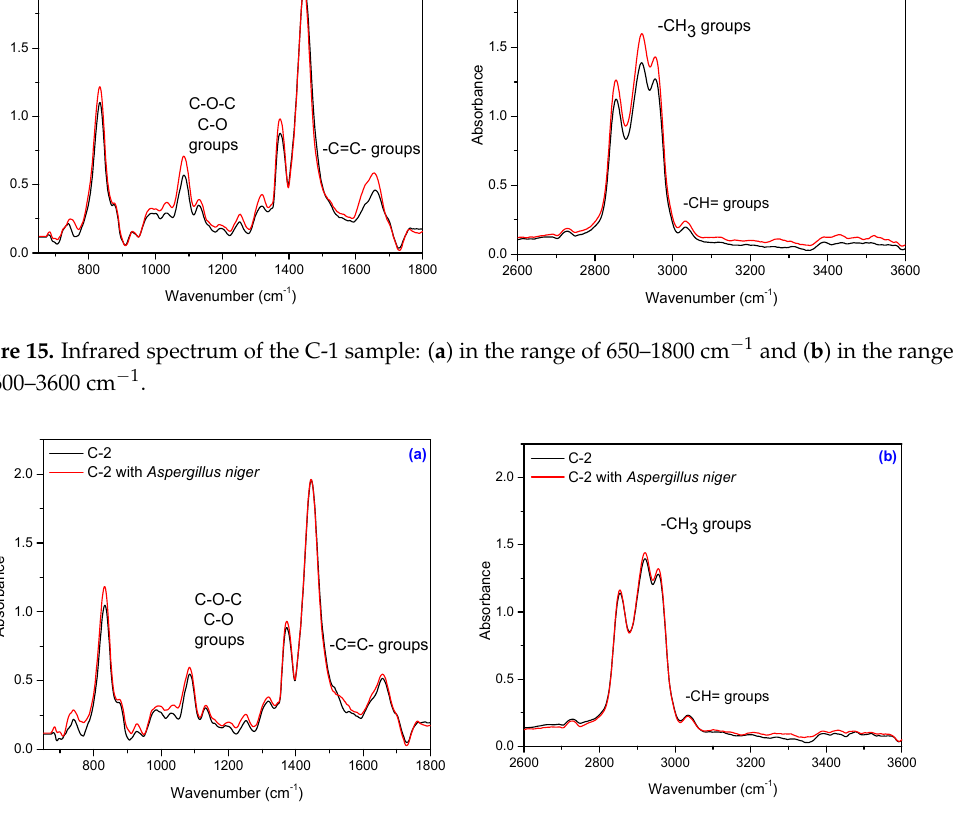
Figure 16. Infrared spectrum of the C-2 sample: ( a ) in the range of 650–1800 cm − 1 and ( b ) in the range of 2600–3600 cm − 1 .